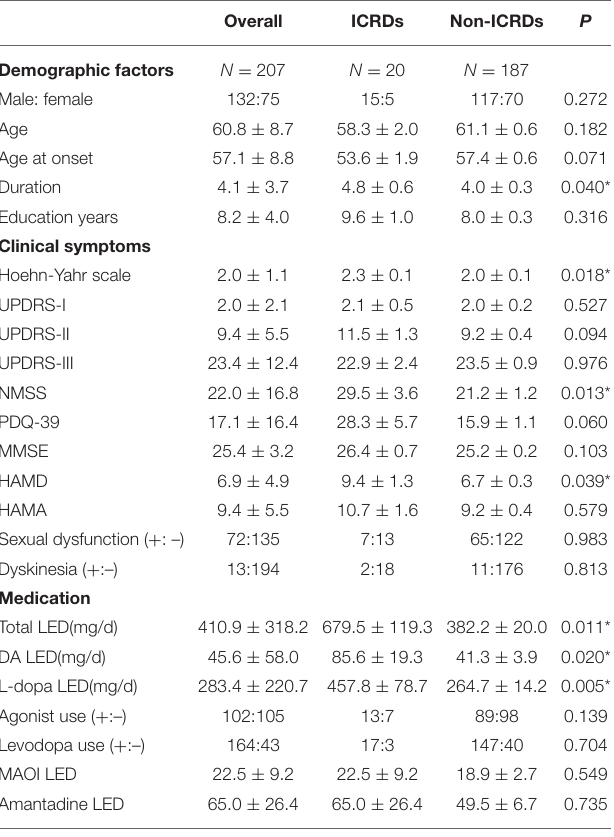
TABLE 3 | Comparisons of demographic factors, clinical symptoms, and medications between patients with and without ICRDs. Overall ICRDs